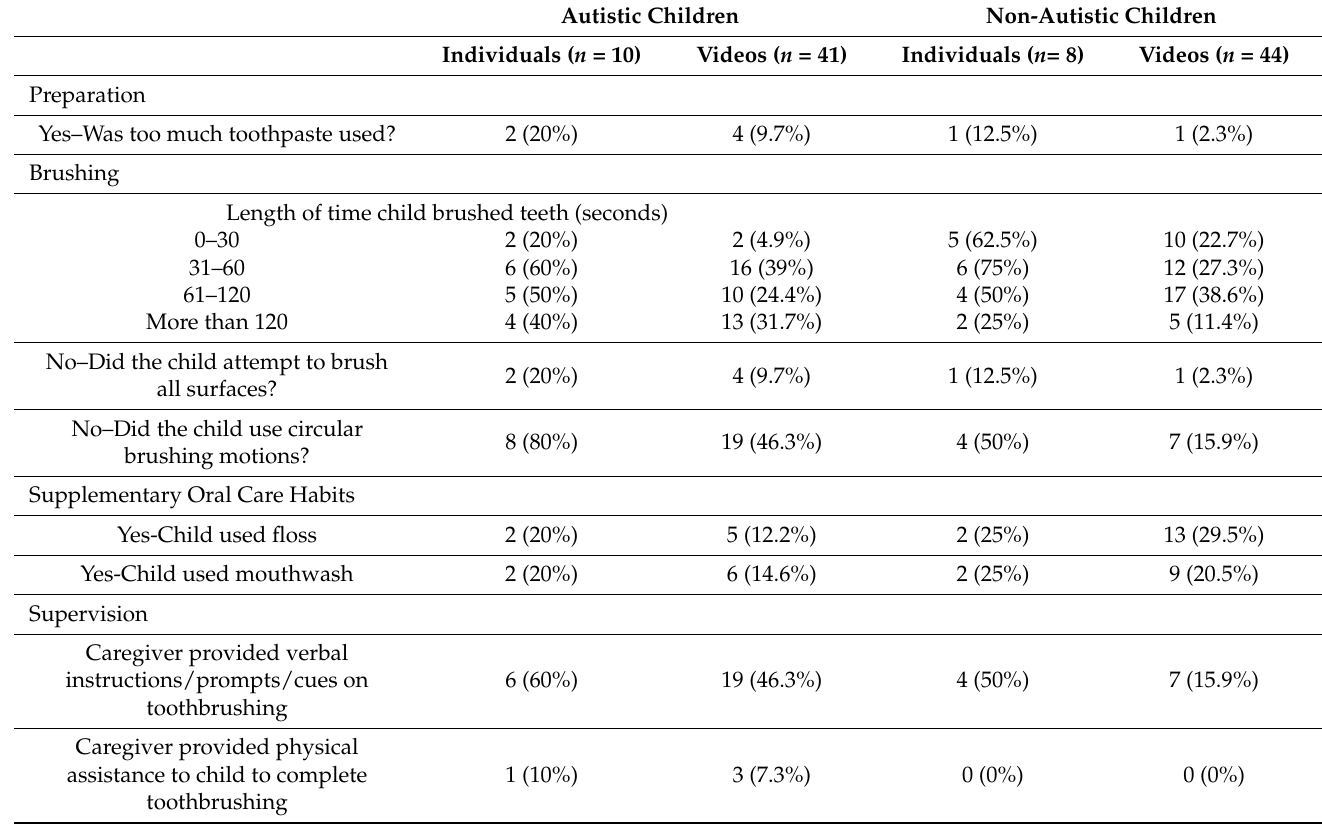
Table 3. Frequency of key features from the Oral Care Observation Guide by autistic and non-autistic